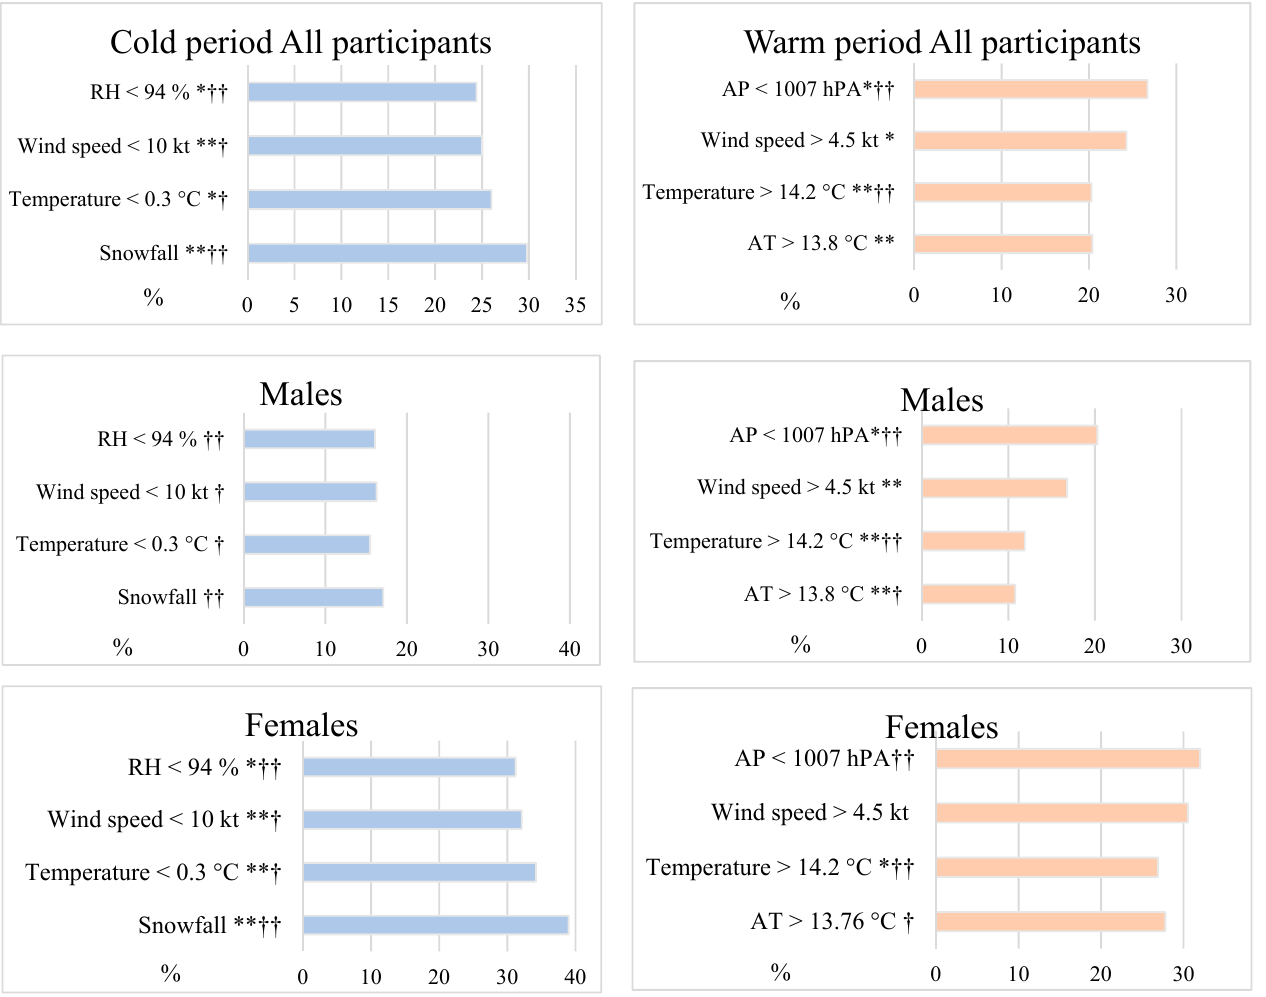
Figure 1. The distribution of the rate of DS by meteorological factors during the cold and warm periods. * p < 0.05, ** p < 0.01; †—the day before the survey; ††—2 days before the manifestation of depressive symptoms; RH—relative humidity; AP—atmospheric pressure; AT—apparent temper- ature.